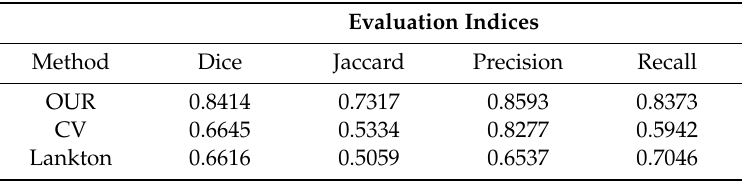
Table 4. Average